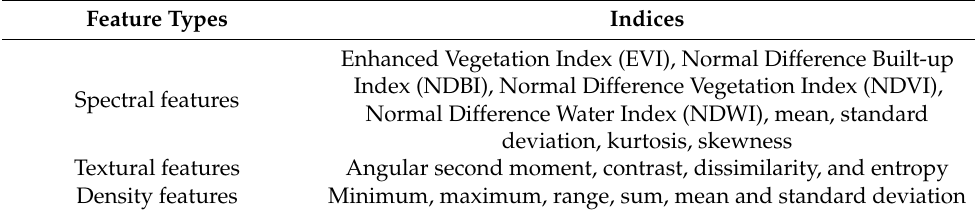
Table 3. Spectral and textural features from RS, and density features from GBD used in FI-based